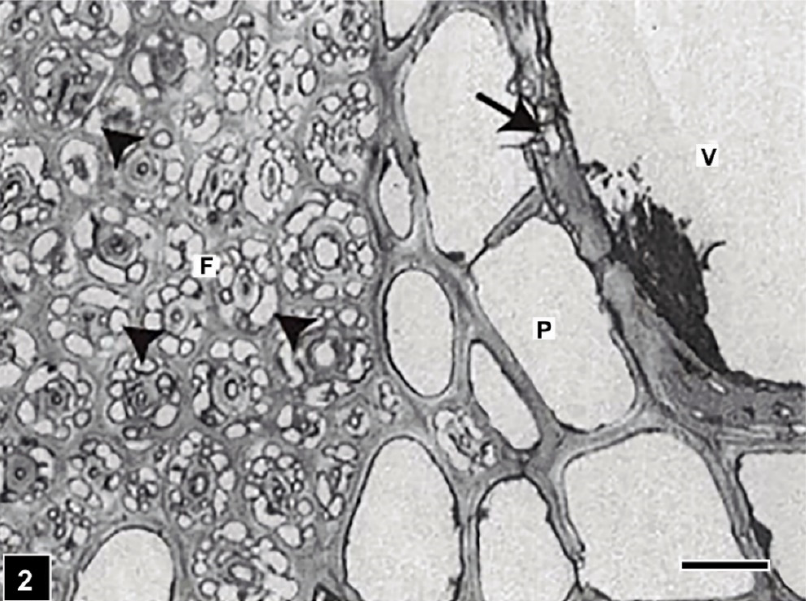
Figure 2. LM of a transverse section through Koompassia malaccensis wood attacked by soft rot. Many soft-rot cavities are present in fibre (F) walls (arrowheads), but only a few in the vessel (V) wall (arrow). P, parenchyma. Scale bar = 20 µm. The image is reproduced from Singh et al. (2018) IAWA J.